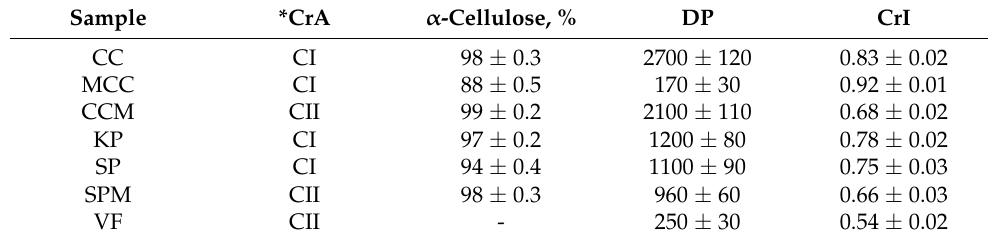
Table 1. Characteristics of cellulose